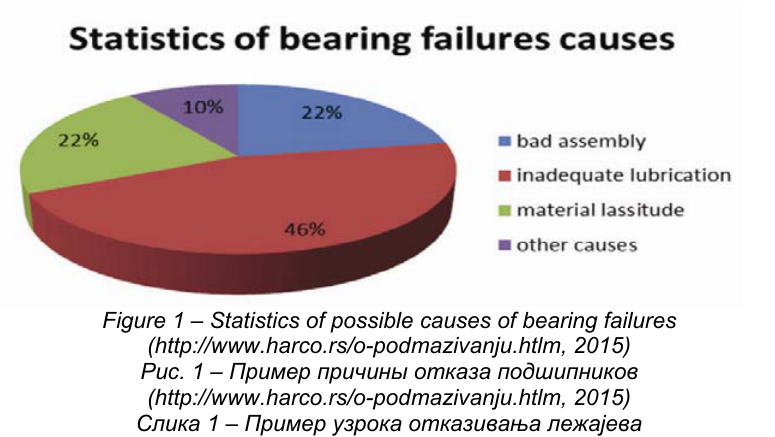
Figure 1 – Statistics of possible causes of bearing failures (http://www.harco.rs/o-podmazivanju.htlm, 2015) Рис . 1 – Пример причины отказа подшипников (http://www.harco.rs/o-podmazivanju.htlm, 2015) Слика 1 – Пример узрока отказивања лежајева (http://www.harco.rs/o-podmazivanju.htlm,